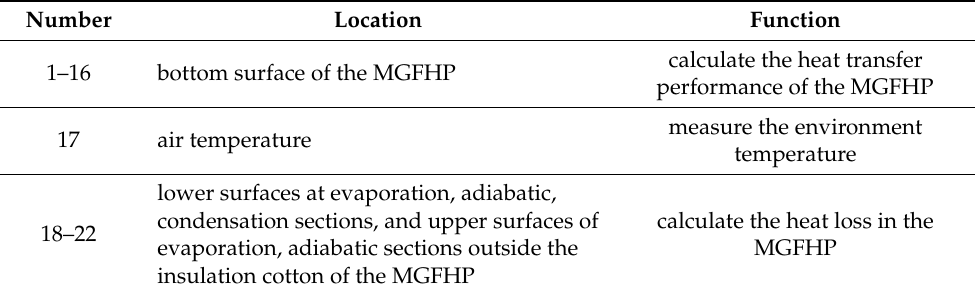
Table 2. Location and function of calibrated thermocouples.